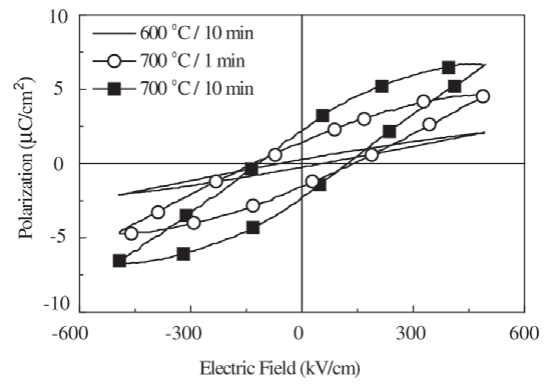
Figure 3. Ferroelectric hysteresis loops dependence on the anneal- ing condition.